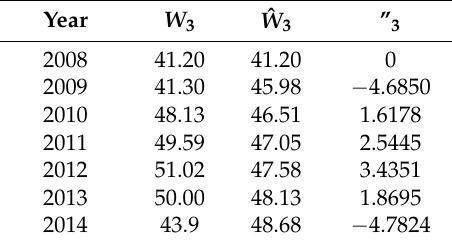
Table 5. Simulation results of W 3 .